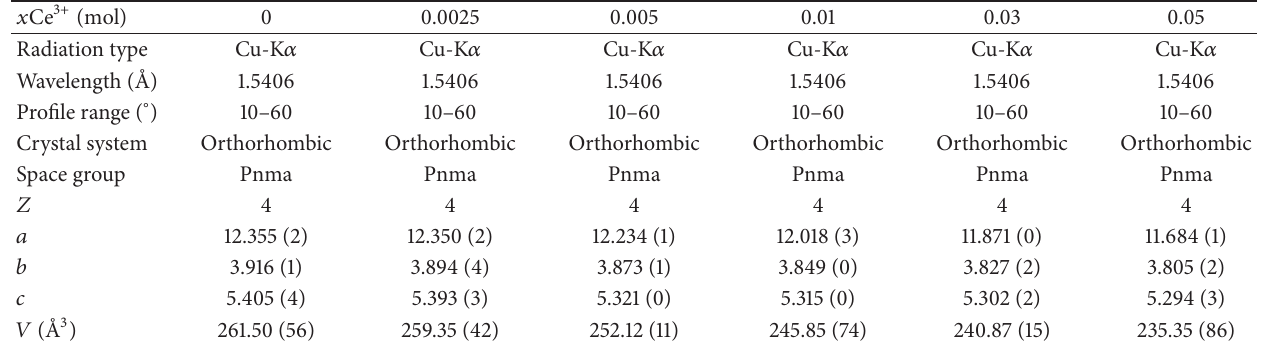
Table 1: Crystal data of Sr 3−𝑥 B 2 SiO 8 : 𝑥 Ce 3+ ( 𝑥 = 0 ∼ 0.05) phosphors.